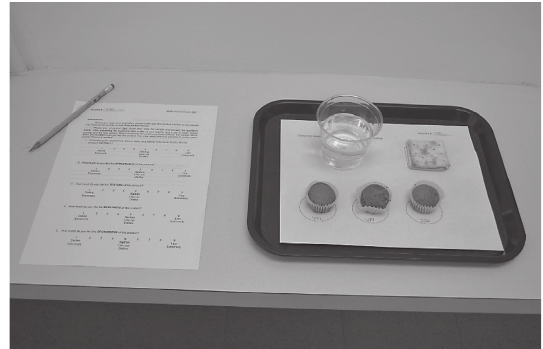
Figure 1: Sensory evaluation ballot and tray setup. Each panelist received a ballot, pencil, and tray with three muffin samples pre- sented in a randomized and balanced order, two saltine crackers, and drinking water to cleanse their palates between each muffin